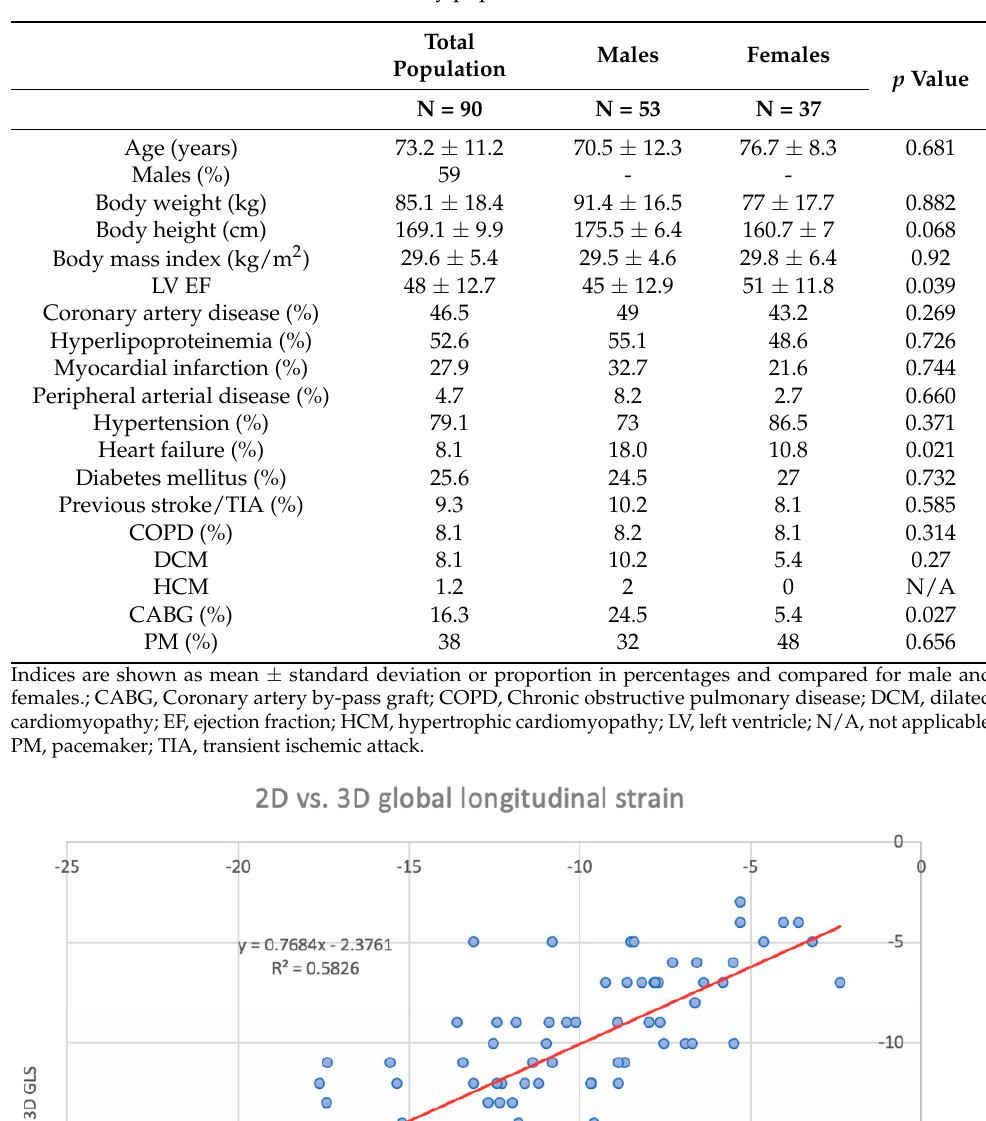
Table 1. Baseline characteristics of the study population.